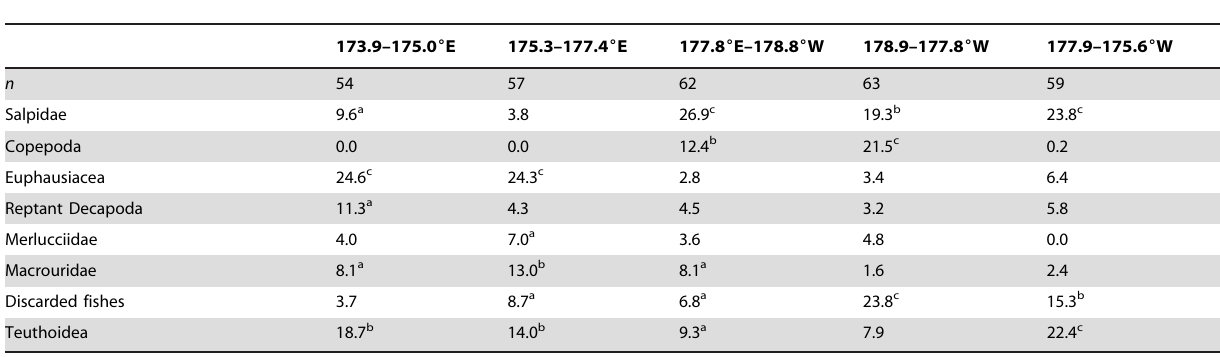
Table 3. Squalus acanthias diet by longitude.